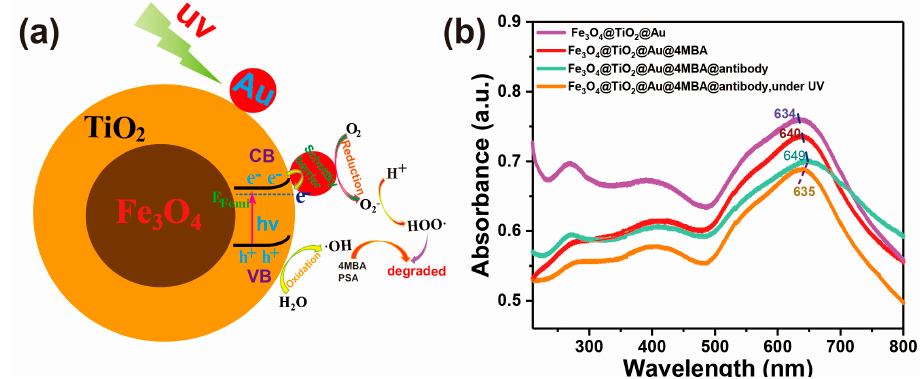
Figure 5. ( a ) The photocatalytic mechanism of Fe 3 O 4 @TiO 2 @Au nanocomposites; ( b ) Absorption spectra of Fe 3 O 4 @TiO 2 @Au, Fe 3 O 4 @TiO 2 @Au@4MBA, Fe 3 O 4 @TiO 2 @Au@4MBA@antibody, and Fe 3 O 4 @TiO 2 @Au recovered by UV irradiation after immunoassay.